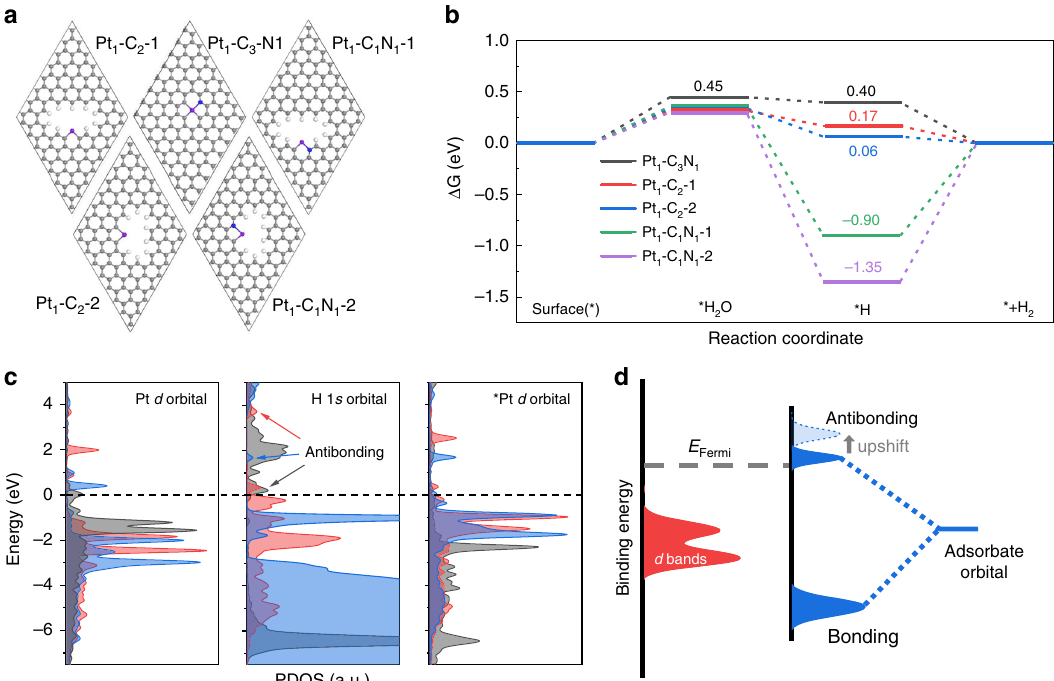
Fig. 3 Theoretical investigations. a Computational models of the Pt 1 -C 3 N 1 and two Pt 1 -C 2 and two Pt 1 -C 1 N 1 moieties. H, white; C, gray; N, blue; Pt, purple. b Calculated adsorption energies of H 2 O and H on the surface of Pt 1 -C 3 N 1 , Pt 1 -C 2 and Pt 1 -C 1 N 1 . c Calculated PDOS of Pt d orbital of clean surfaces, H 1 s of hydrogen adsorbed on Pt sites and Pt d of Pt sites with adsorbed hydrogen (denoted *Pt d orbital), from left to right, respectively. The gray, red and blue contour represent Pt 1 -C 3 N 1 , Pt 1 -C 2 -1, and Pt 1 -C 2 -2 surfaces, respectively. The DOS peaks of H1 s -Pt 5 d antibonding are indicated by the arrows. Note that the sharp peak ∼ − 1 eV for Pt 1 -C 2 -2 represent bonding rather than antibonding state, as it corresponds to the prominent Pt d band in the *Pt d PDOS. d Schematic DOS illustration of the interaction between Pt and H, the H 1 s states split into bonding and antibonding states. With four-coordinate Pt evolving to two-coordinate, the corresponding antibonding states upshift to a higher energy with a lower